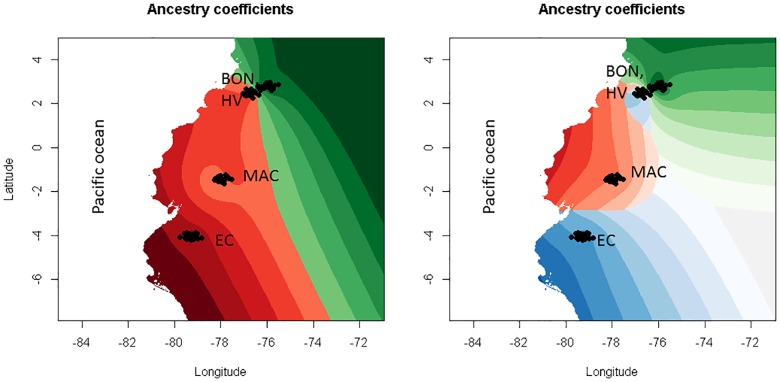
Geographical representation of the interpolation of admixture coefficients (Q matrix) for clusters k2 and k3 including MAC, EC BON and HV breeds only.Each color represents the genetics partitions spotted on geographical surface through Kriging algorithm.